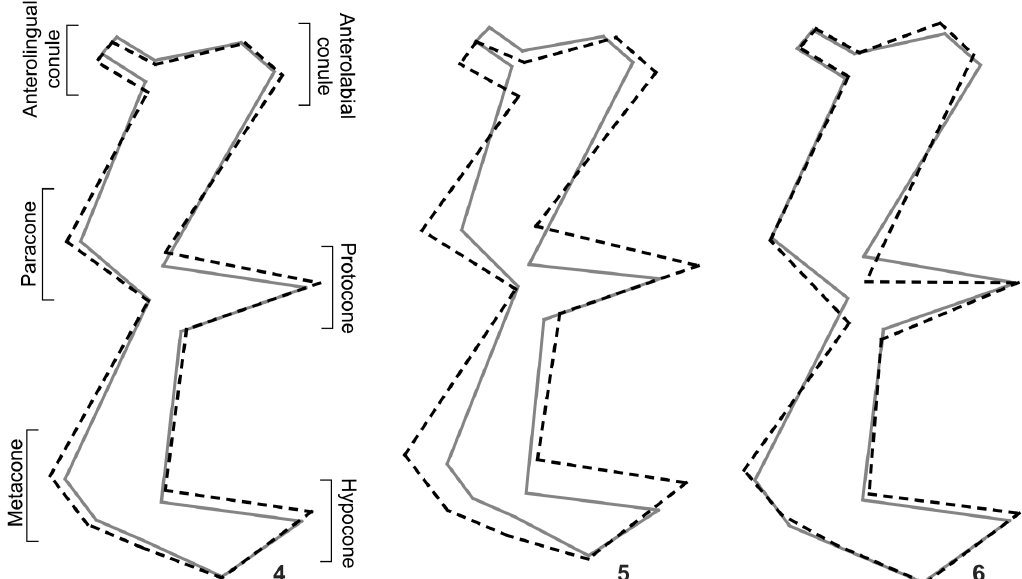
Figures 4–6. Shape differences wireframes in PC1. Gray solid lines indicate C. tener (positive PC1 values) and black dotted lines indicate C. expulsus (negative PC1 values), see Fig. 3 for individual projections. ( 4 ) Differences between the mean shapes of C. tener and C. expulsus ; ( 5 ) differences between the disparate shape of C. tener represented by CT 05 and C. expulsus represented by CE 09; ( 6 ) shape differences wireframes in PC2. Gray solid lines indicate the mean of shape of PC2 value and black dotted lines indicate specimen CT 02 ( C. tener ZOOLOGIA 34: e19864 | DOI: 10.3897/zoologia.34.e19864 | August 22, 20176 /